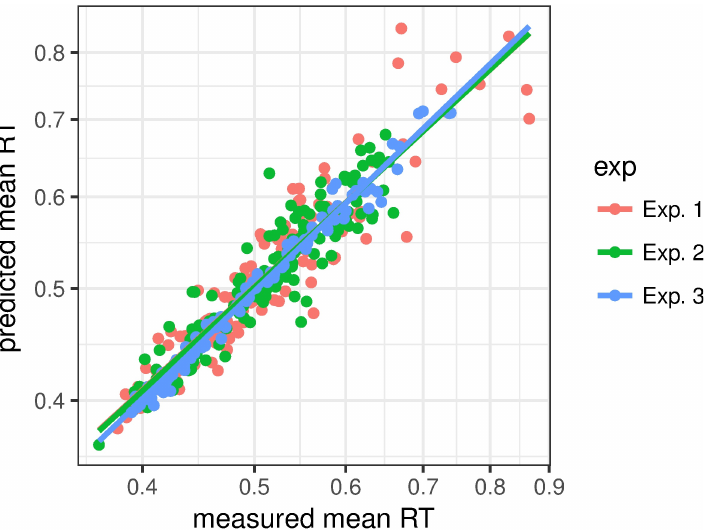
Fig 11. Scatterplot of predicted vs. observed mean RTs for all experiments, participants, ratio conditions, and inter-trial conditions, for each experiment. Lines show the corresponding linear fits.